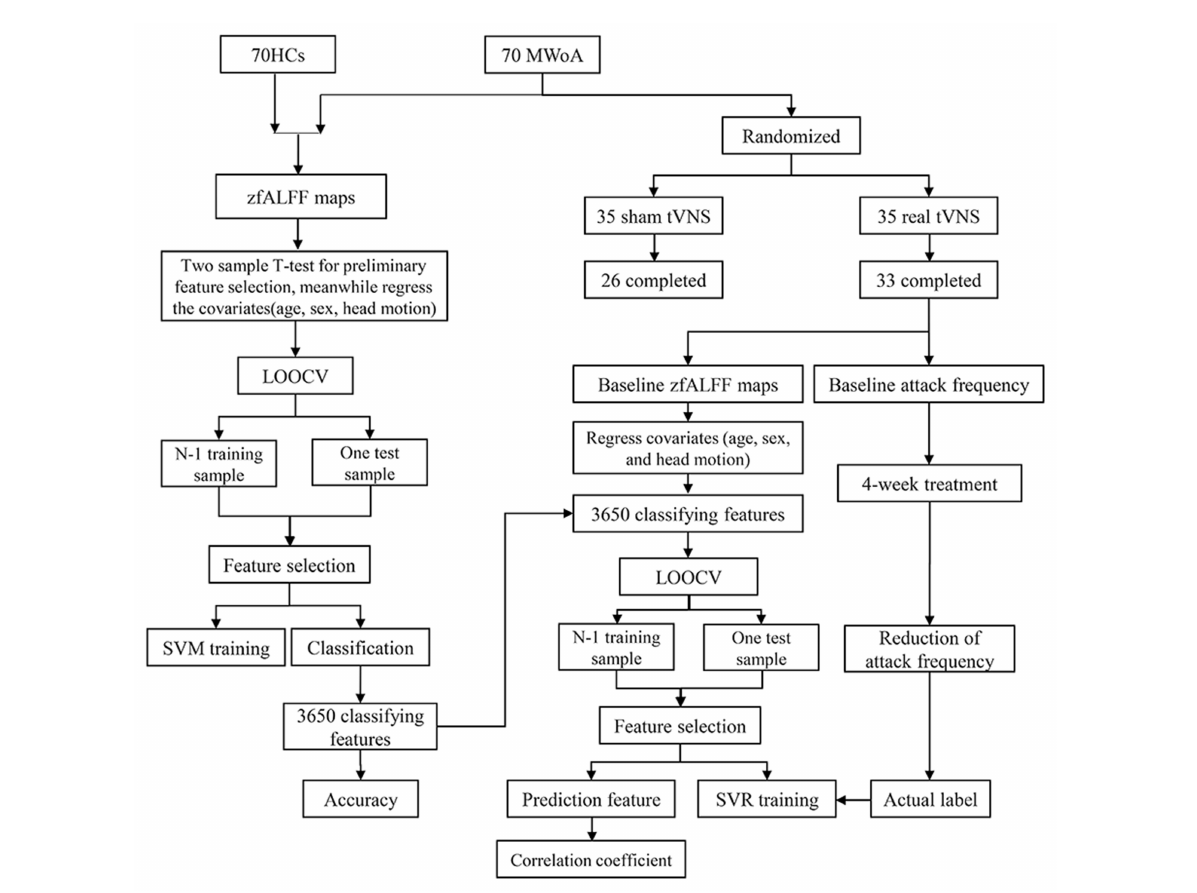
FIGURE1 The flow diagram of classification and prediction. A total of 70 HCs and 70 MWOA were used to construct the classification model and the top 3,650 discriminative features could discriminate MWoA with the highest accuracy. Then, the 3,650 discriminative features were used to construct predicting model and 70 predictive features could predict the reduction of migraine attack frequency with the highest correlation coefficient. HCs, healthy controls; MWOA, migraine without aura; LOOCV, leave-one-out cross-validation; SVM, support vector machine; SVR, support vector